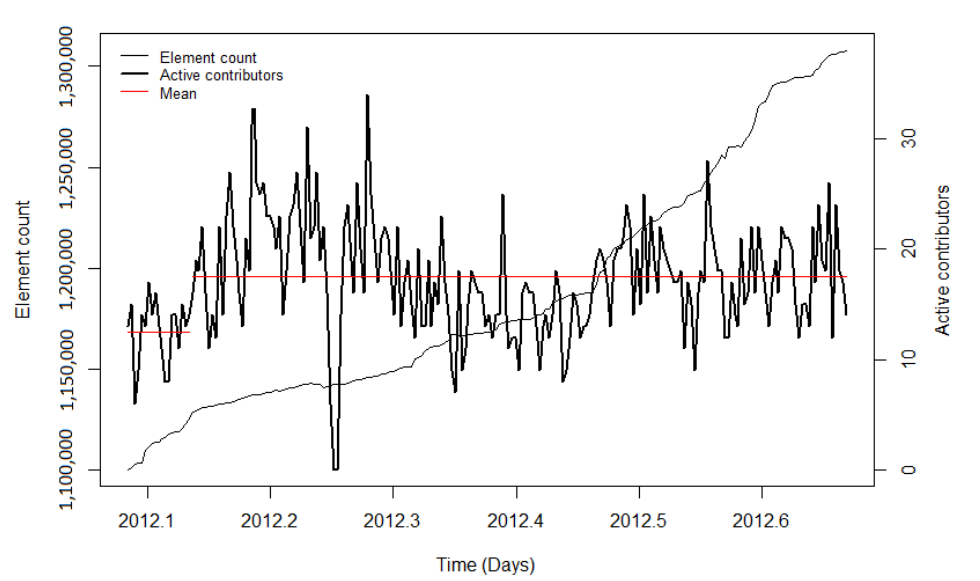
Figure A7. Contributor activity during the observation period without a large data import in